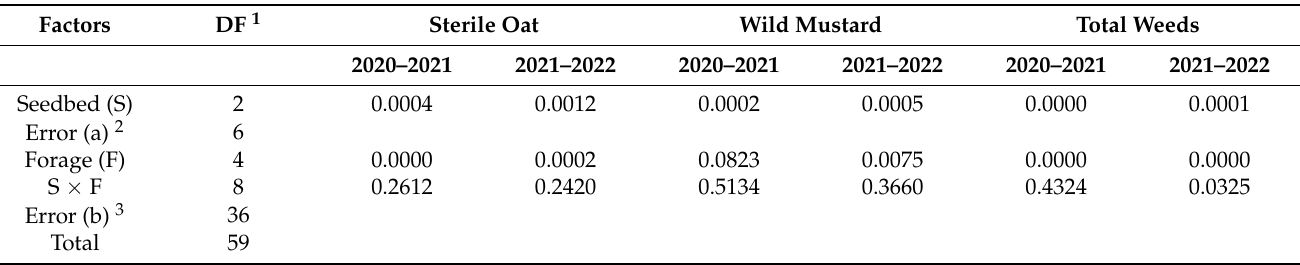
Table 2. Overall statistical analyses of degrees of freedom (for seedbed factor; for forage factor; for seedbed and forage interaction; for the error) and of the significance of effect (seedbed; forage; seedbed and forage interaction and tests performed) on sterile oat density, wild mustard density, and total weed density. Data are presented separately for the two growing seasons (2020–2021 and 2021–2022).